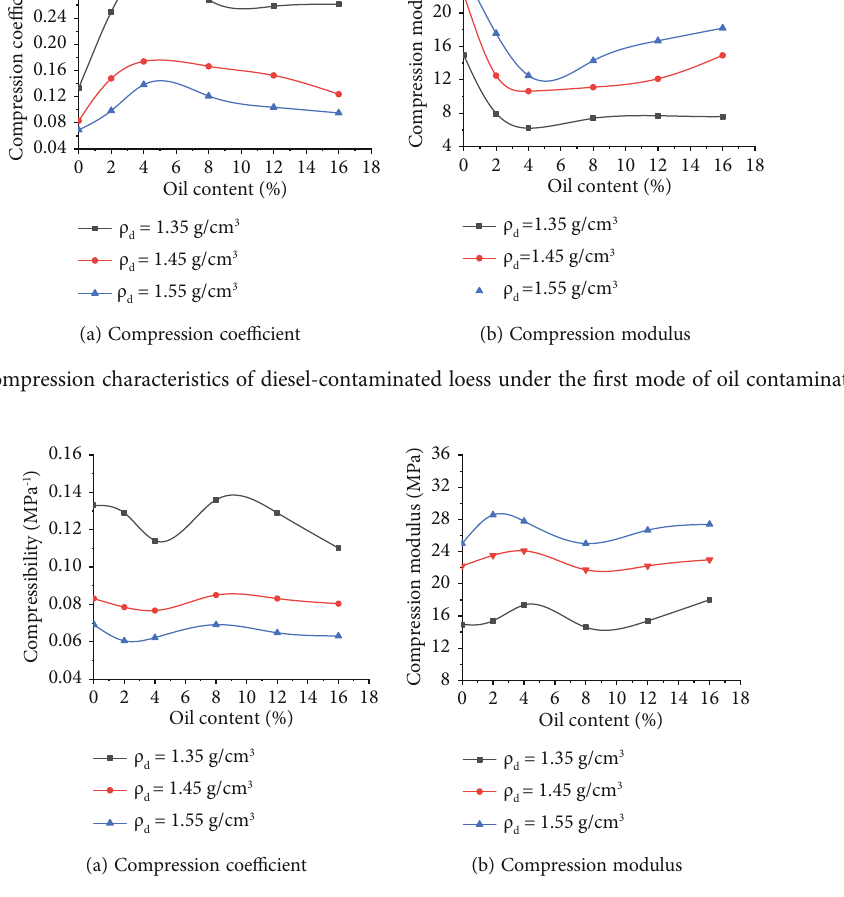
Figure 5: Compression characteristics of diesel-contaminated loess under the second mode of oil contamination. Table 4: Results of direct shear tests under the two di ff erent modes of oil